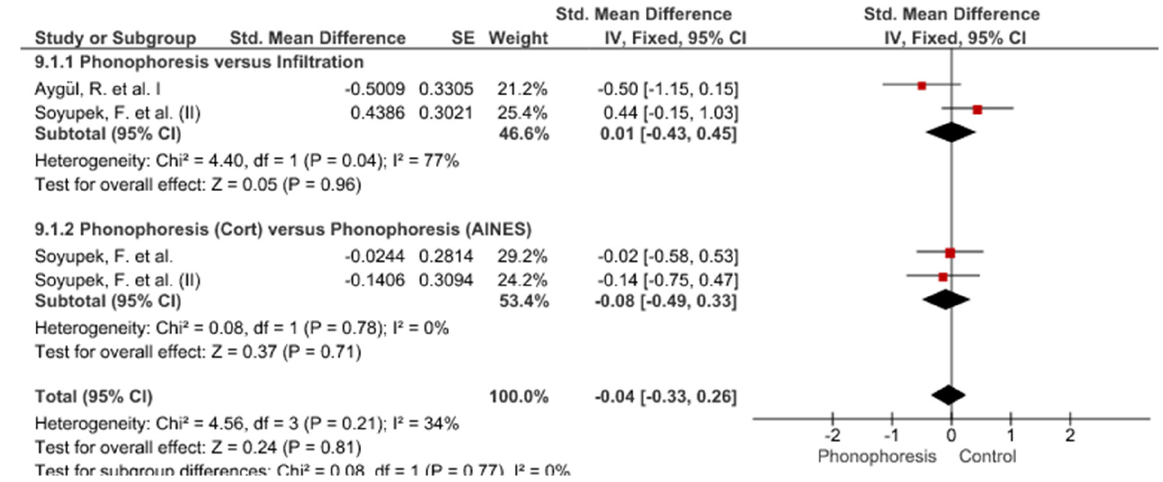
Figure 9. Phonophoresis for SNAPam.